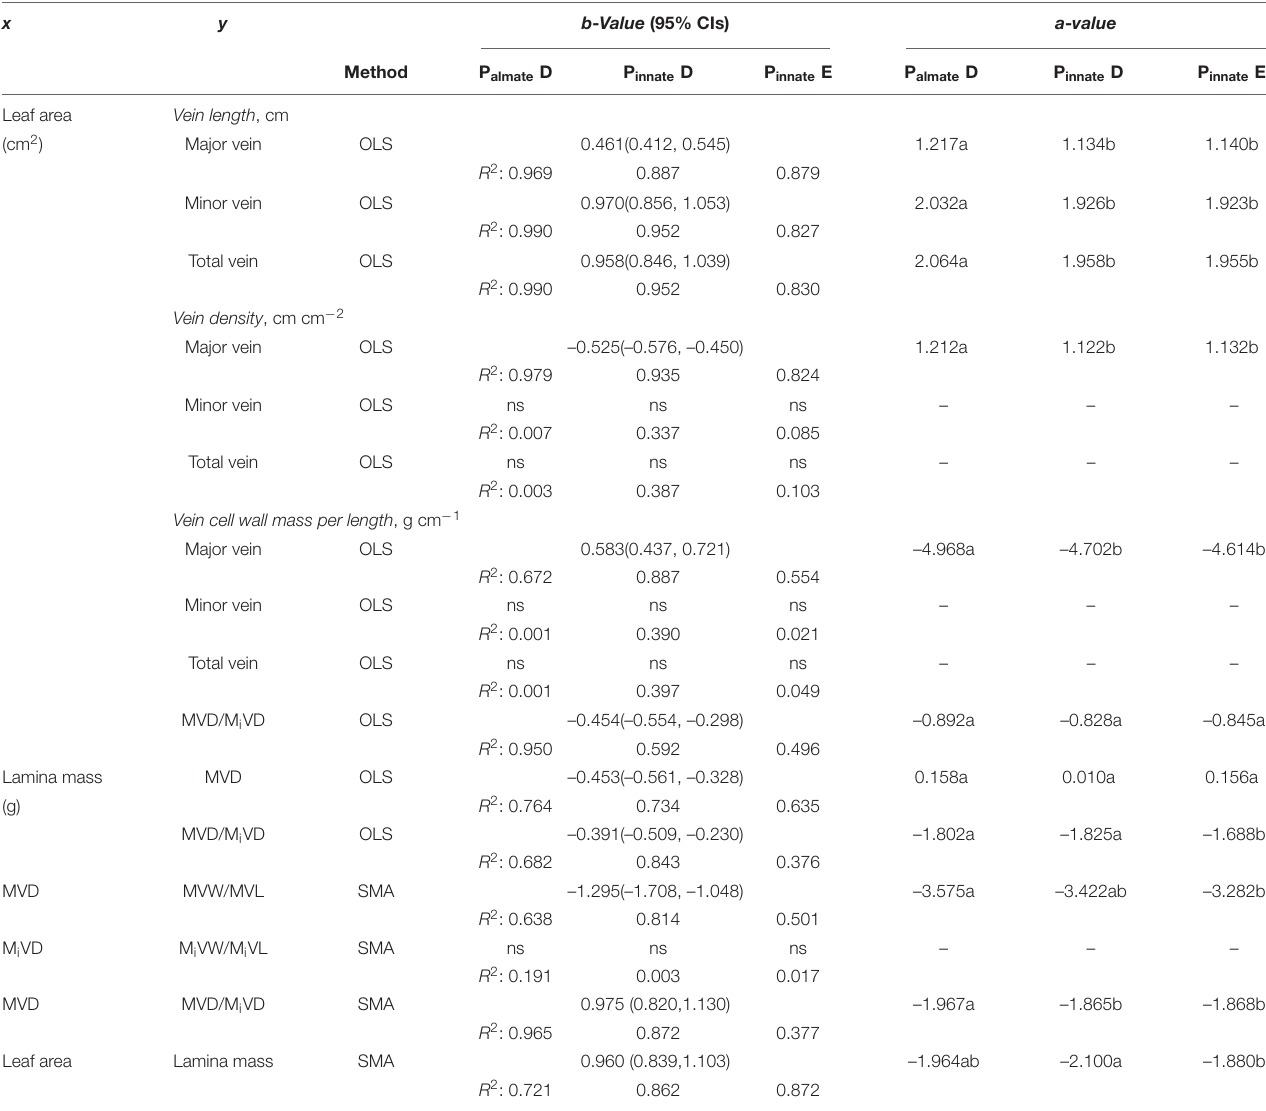
TABLE 1 | Parameters for the scaling relationships of vein traits and leaf